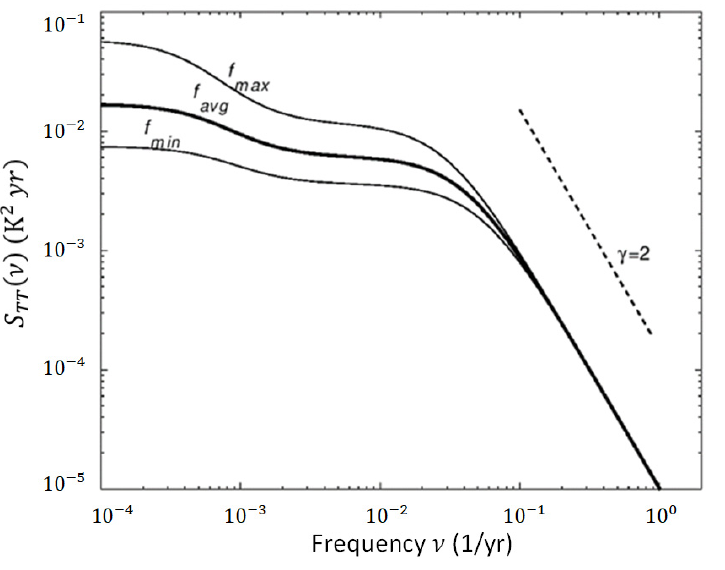
Figure 4. Power spectra of the global mean surface temperature fluctuations that were obtained from the two-box random energy balance model for different values of the feedback coefficient f . The dashed line shows the characteristic 1 𝜈 (cid:2870) ⁄ slope.